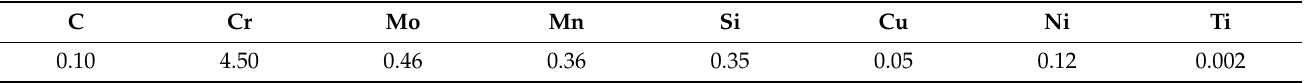
Table 1. Chemical composition (wt %) of the present work’s